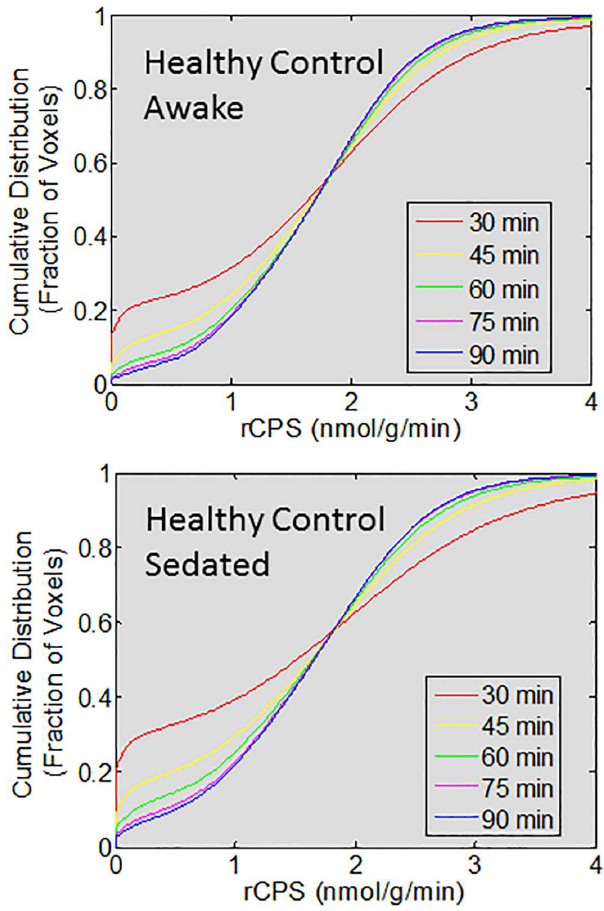
Fig 3. Cumulative probability distribution of rCPS. The ordinate is the fraction of the total brain voxels at each of the rCPS levels shown on the abscissa. Data are from 1.9x10 6 voxels in the brain of a healthy 23 year old male studied awake and under propofol sedation. Values of rCPS were estimated on an interval of 30 min (red), 45 min (yellow), 60 min (green), 75 min (magenta), and 90 min (blue). rCPS was computed for each voxel in the brain from the rate constants of the homogeneous tissue kinetic model estimated with the Basis Function